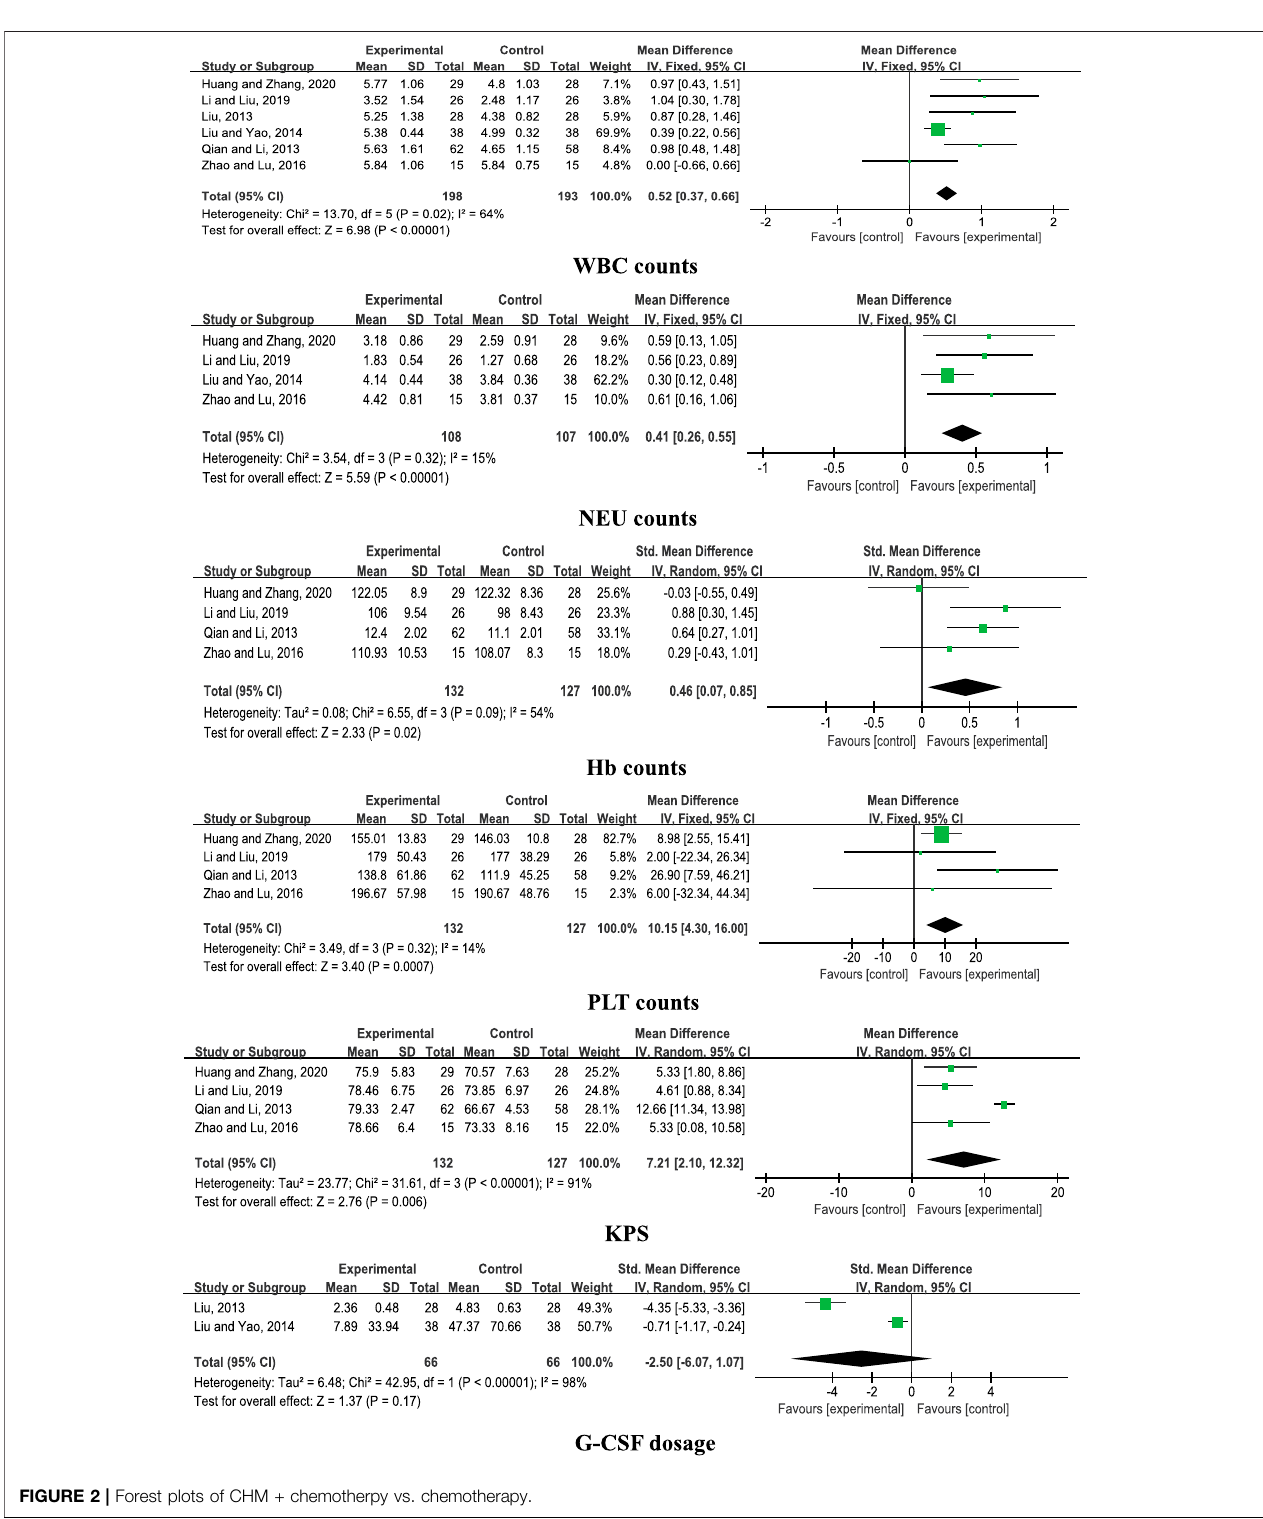
FIGURE 2 | Forest plots of CHM + chemotherpy vs.